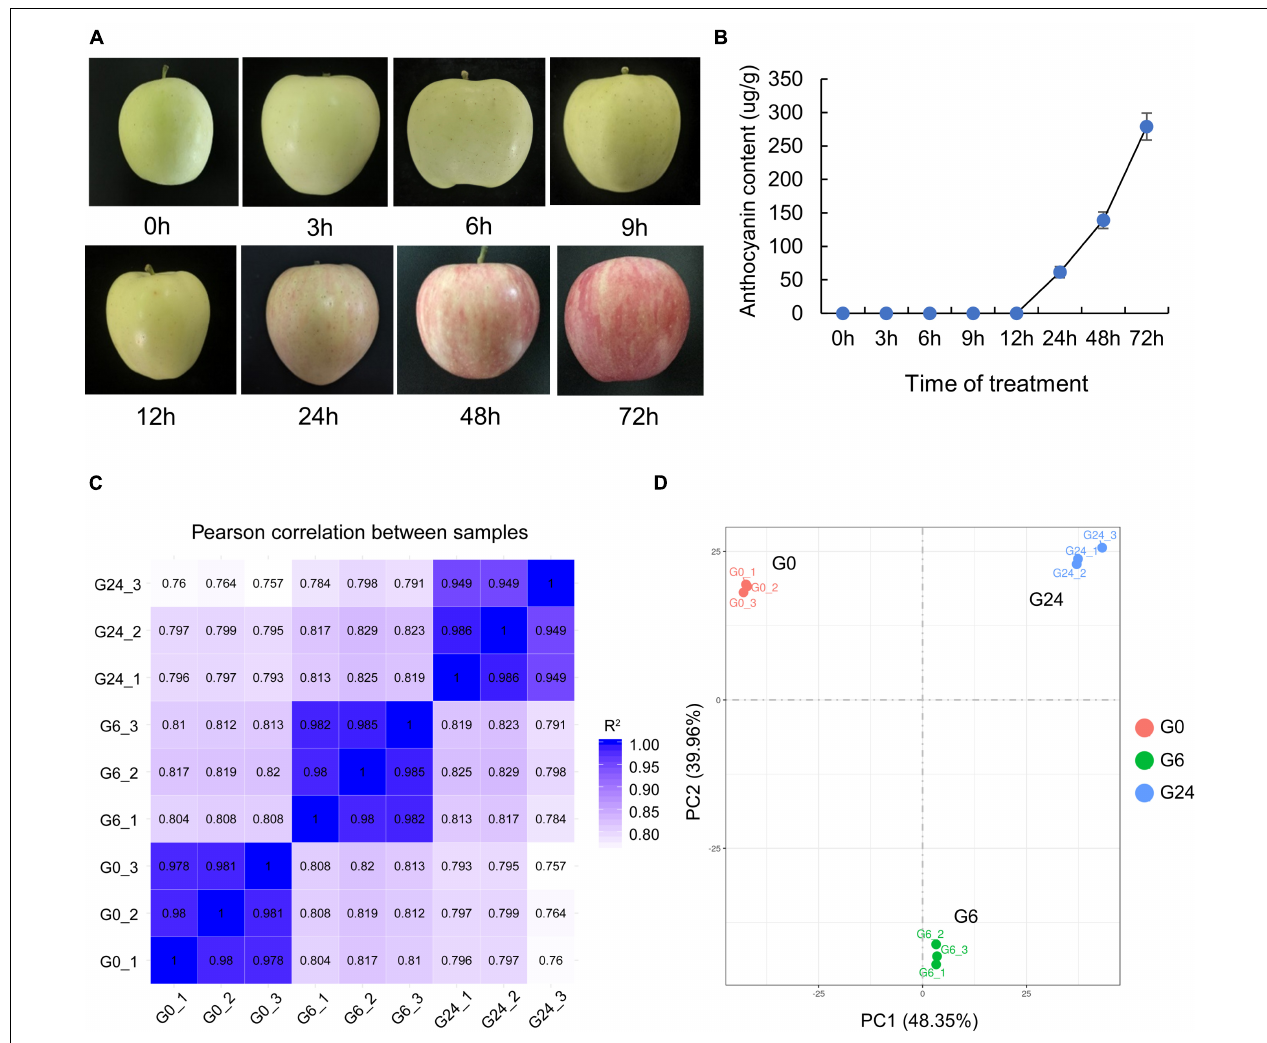
FIGURE 1 | RNA-seq data of “Starkrimson Delicious” apple fruit exposed to light after unbagging. (A) Change in color of “Starkrimson Delicious” fruit peel under light. (B) Anthocyanin content in the peel under light. (C) Pearson correlation between samples. (D) Principal component analysis of the RNA-seq data.